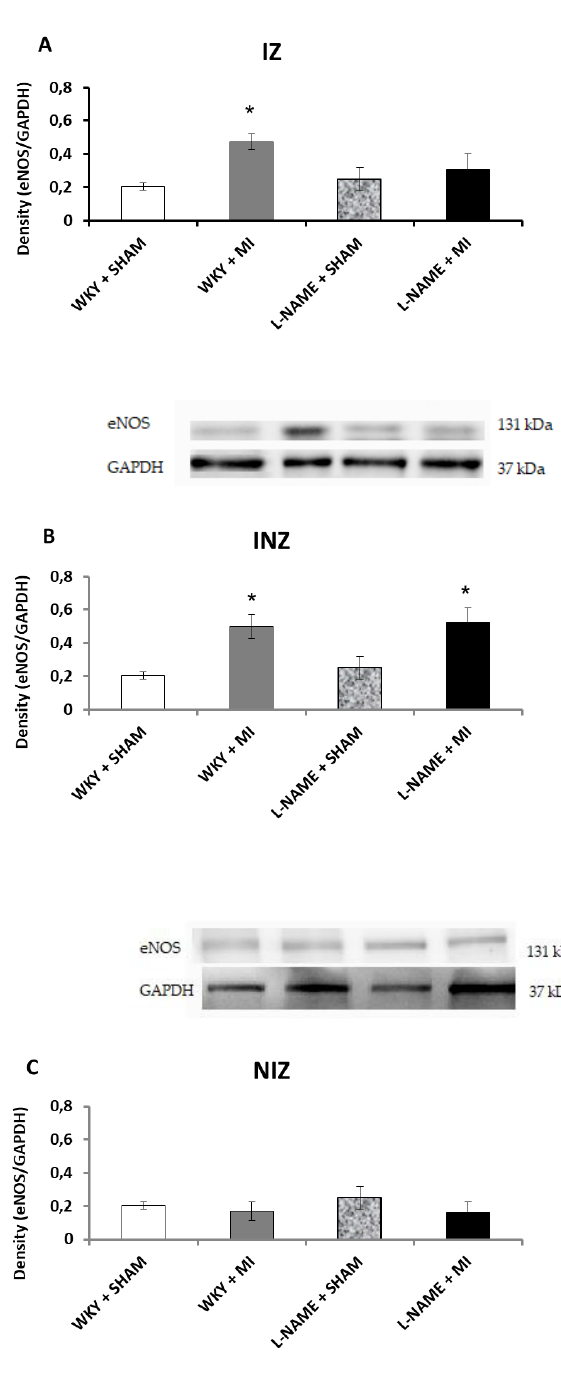
Figure 2. The effect of myocardial infarction on endothelial NOS (eNOS) expression of infarcted zone (A), injured zone (B) and non-infarcted zone (C) of myocardium. Representative western blot images and relative eNOS expression levels of sham operated Wistar Kyoto rats (WKY + Sham); WKY rats with experimentally induced myocardial infarction (WKY + MI); sham operated WKY rats treated with L-NAME (20 mg/kg/day) (L-NAME + Sham) and L-NAME (20 mg/kg/day) treated WKY rats with experimentally induced myocardial infarction (L-NAME + MI) in infarcted zone (IZ) (A), injured zone (INZ) (B) and non-infarcted zone (NIZ) (C). * p < 0.05 compared to WKY + Sham group; N = 6 in each group.